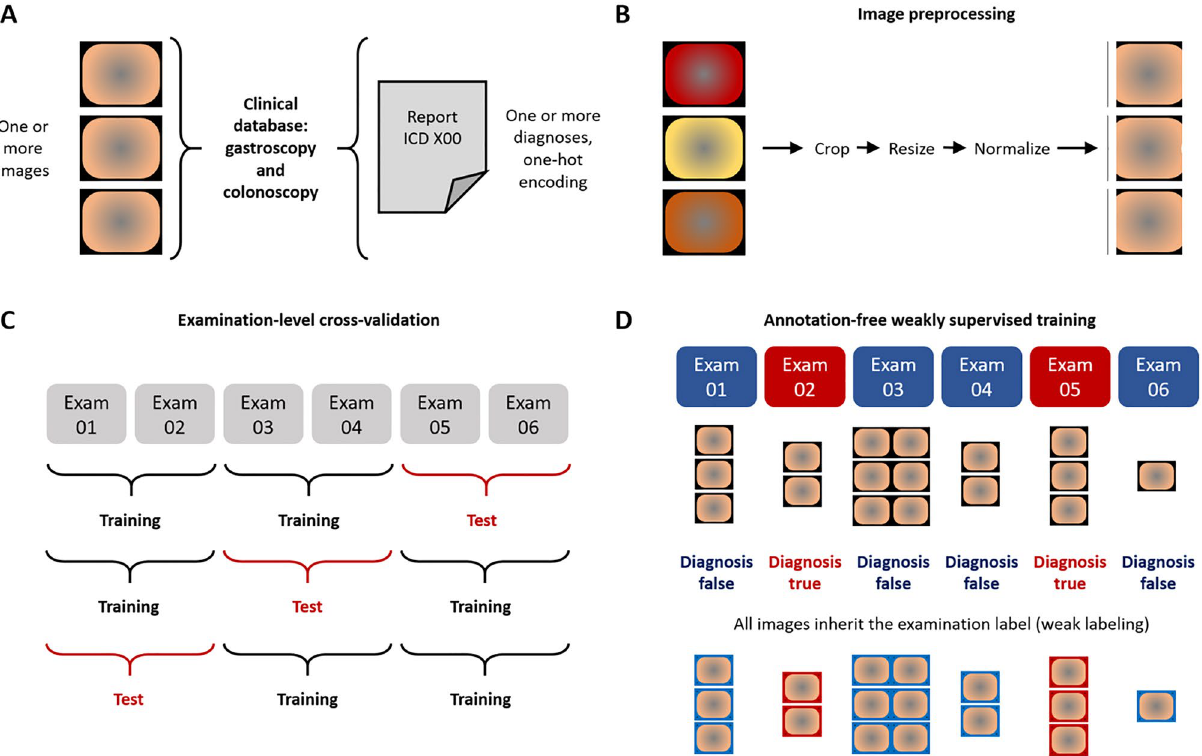
Figure 1. Outline of this study. ( A ) From a large clinical database of gastroscopy and colonoscopy examination, we retrieved images (left) and matched them to disease diagnoses obtained from the corresponding reports (right). ( B ) Images were slightly preprocessed by cropping, resizing and color-normalization by adaptive histogram equalization. ( C ) The experimental workflow relied on examination-level three-fold cross-validation, in which three artificial intelligence (AI) networks were trained for each disease category and the test set was rotated. ( D ) In the weakly supervised AI workflow, all images from a given examination (Exam) inherited the one-hot-encoded disease label. No image-level or pixel-level annotations were